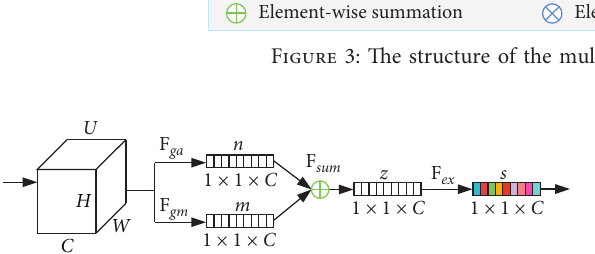
Figure 4: The structure of the feature filtering module